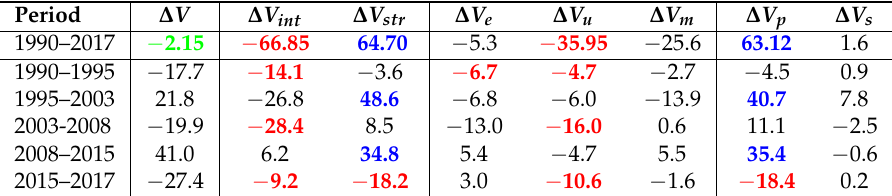
Table 2. Additive IDA-LMDI analysis results (gCO 2 /kWh).